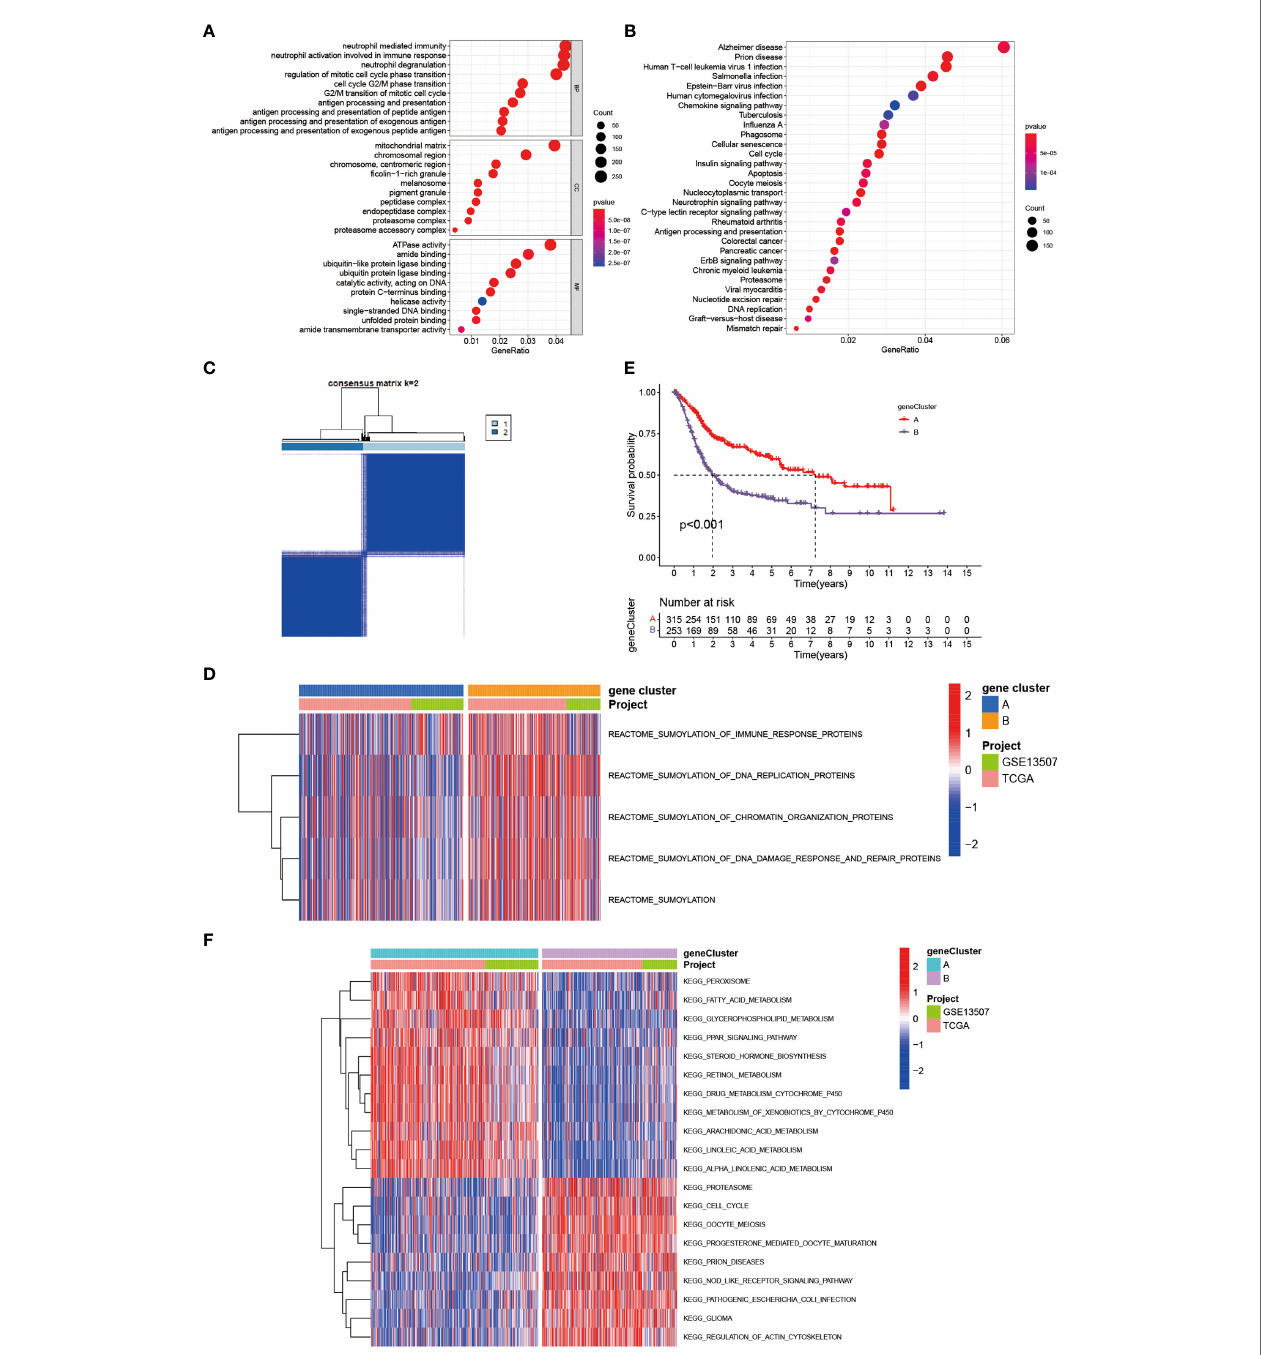
FIGURE 3 | Generation of SUMOylation gene signatures and functional annotation. (A) Functional annotation for SUMO cluster related DEGs using GO enrichment analysis. The color depth of the barplots and plots represented the number of genes enriched. The pathways were grouped by cellular component (CC), molecular function (MF) and biological process (BP). (B) Functional annotation for SUMO cluster related DEGs using KEGG enrichment analysis. The color depth of the barplots and plots represented the number of genes enriched. (C) Unsupervised clustering of 1,934 SUMO cluster related DEGs with prognostic value in meta-cohort and consensus matrices for k = 2. (D) Transcriptome pro fi les of genes involved in SUMOylation and SUMOylation related biological processes between the two distinct gene clusters. (E) Kaplan – Meier curves indicated SUMOylation genomic phenotypes were markedly related to overall survival of 568 patients in meta-cohort, of which 315 cases were in gene cluster A and 253 cases in gene cluster B (P <0.001, Log-rank test). (F) GSVA enrichment analysis showing the activation states of biological pathways in distinct gene clusters. The heatmap was used to visualize these biological processes, and red represented activated pathways and blue represented inhibited pathways. The project and gene cluster were used as sample